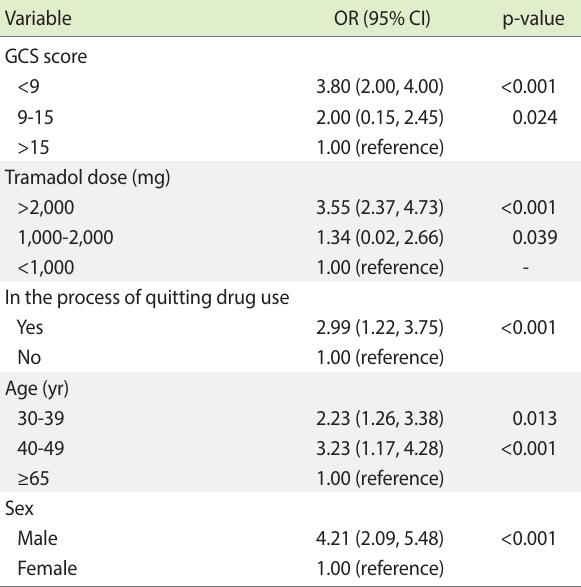
Table 2. Characteristics of seizures